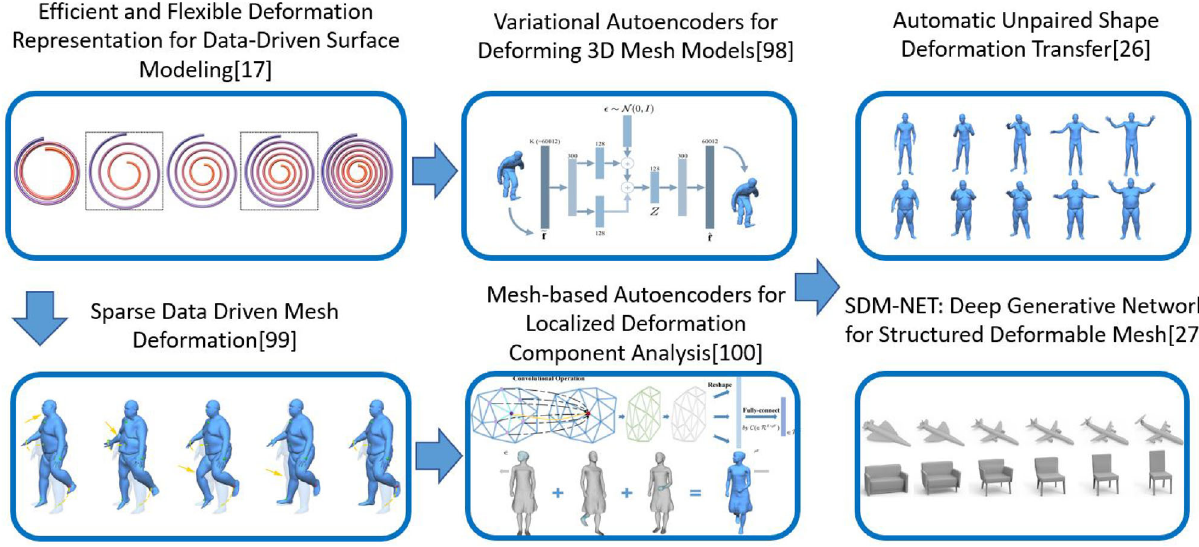
Fig. 4 Deformation-based shape representation used by the geometry learning group, ICT,